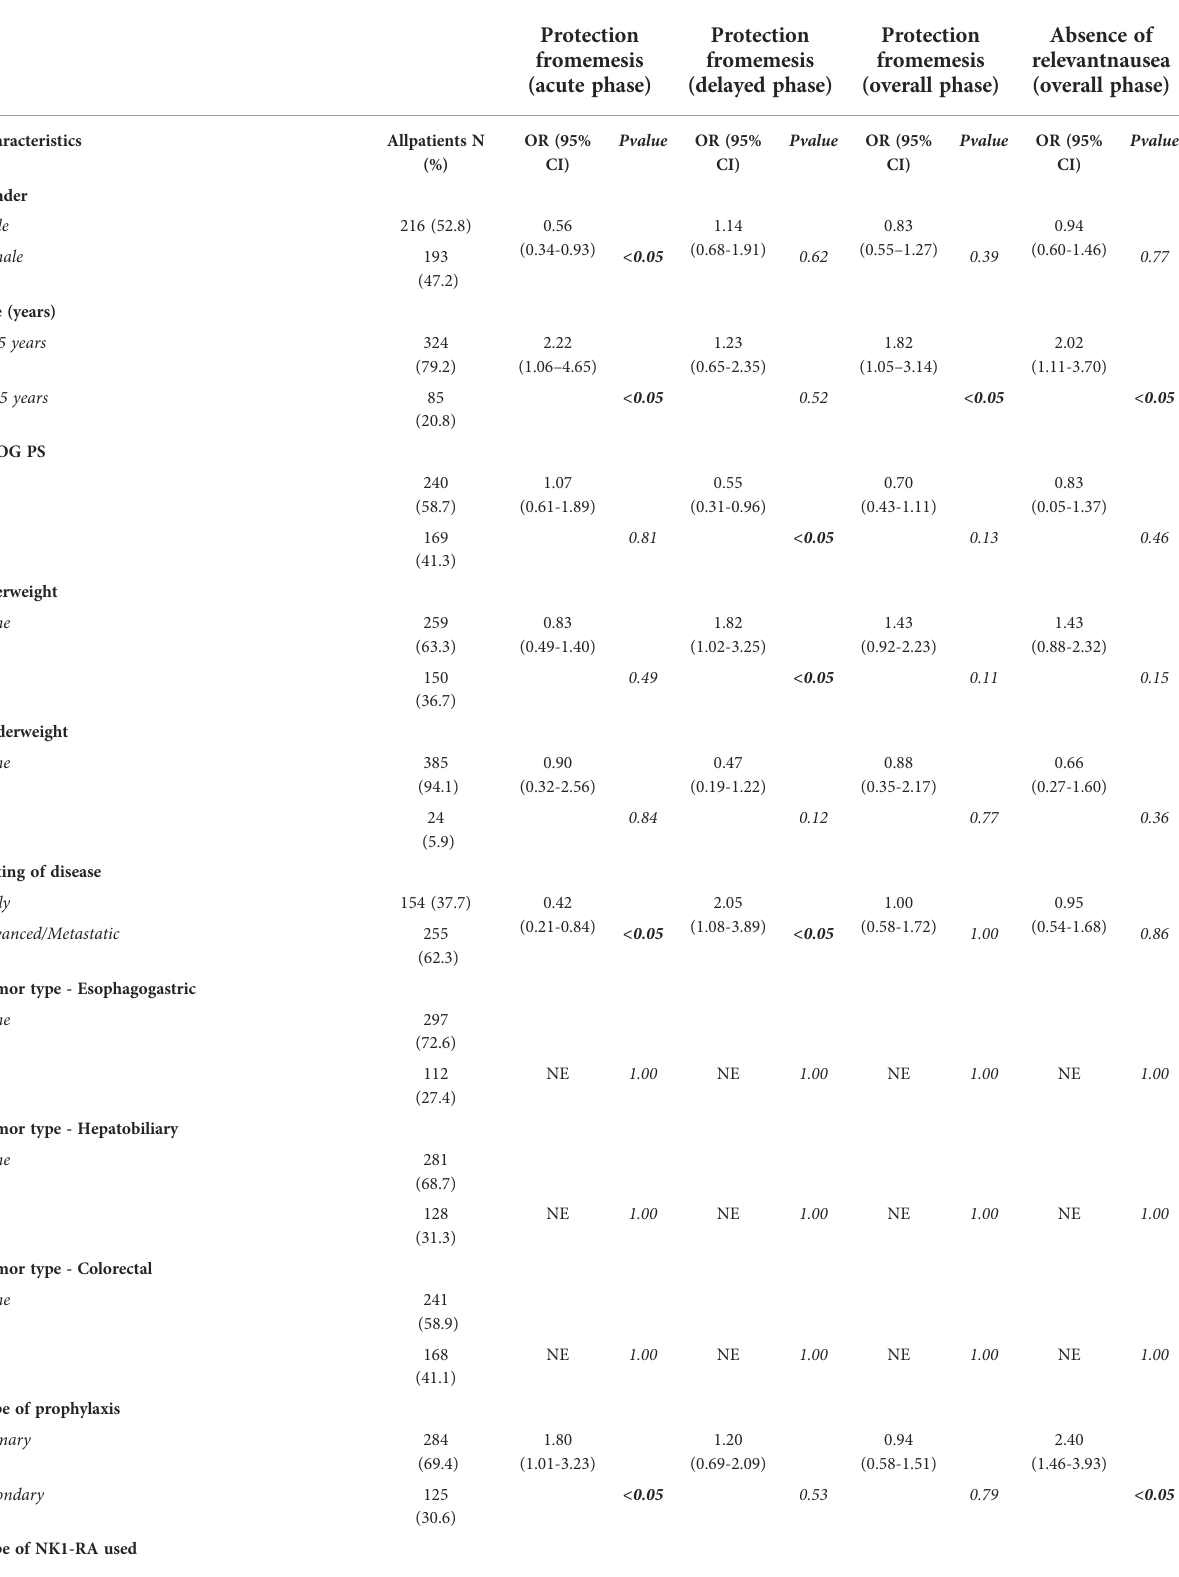
TABLE 2A Multivariate analysis for the effectiveness outcome